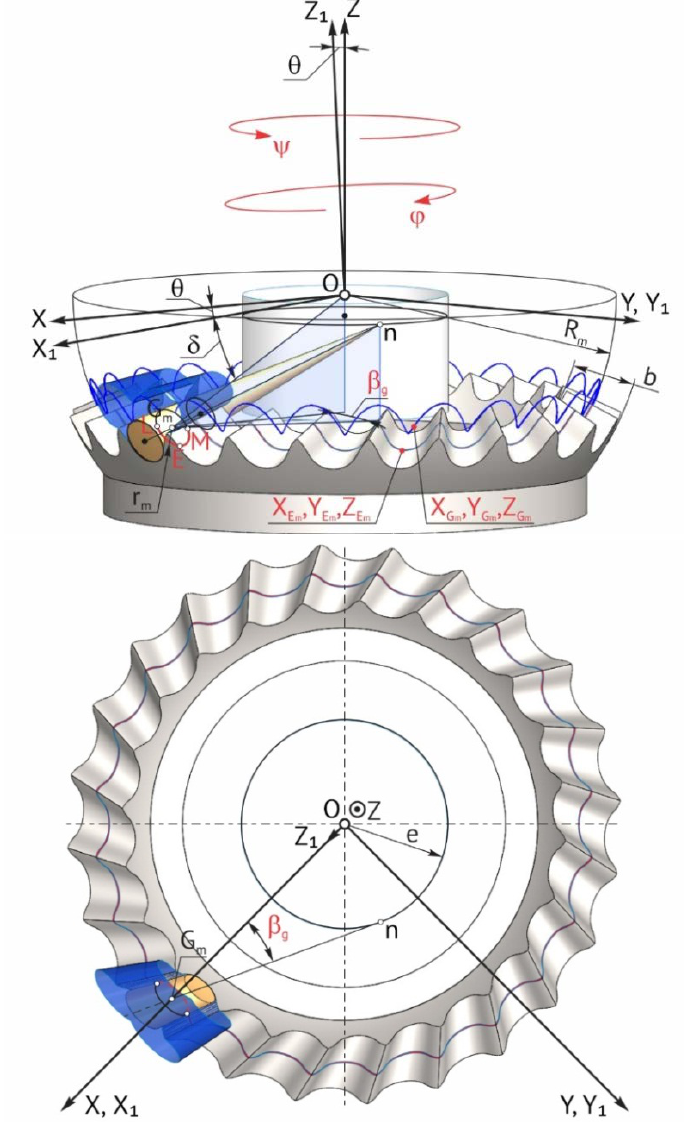
Figure 3. Geometry of the flank surface of the inclined teeth of the central